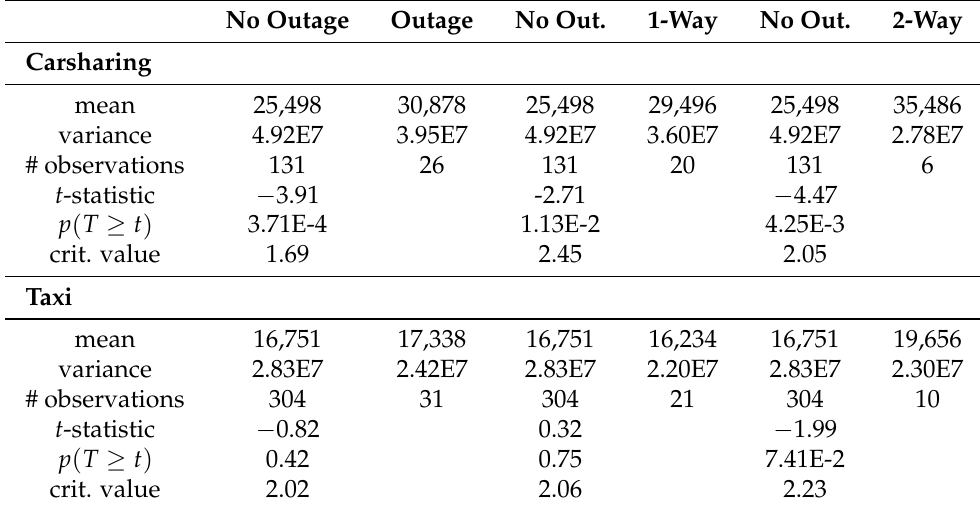
Table 2. Results of the Welch’s t-Test for Changing Demand Patterns during Outages.